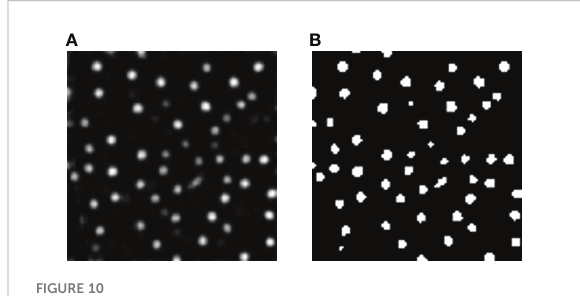
FIGURE 10 Segmentation results optimization. (A) Segmentation results of Ipp Net; (B) Optimized images of the segmentation results.